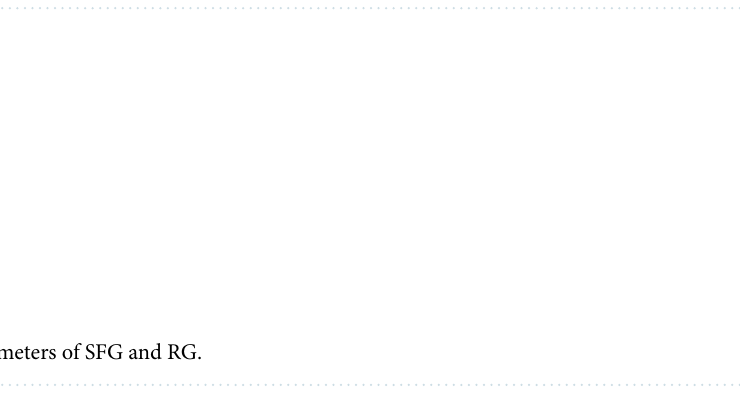
Figure 2. Schematic of ( a ) ( N = 3, t r = 9.77) SFG 4 and ( b ) RG. Positions P 0 to P 22 indicate the individual allocation of piezoelectric thin-film in the lee of ( c ) SFG and ( d ) RG.